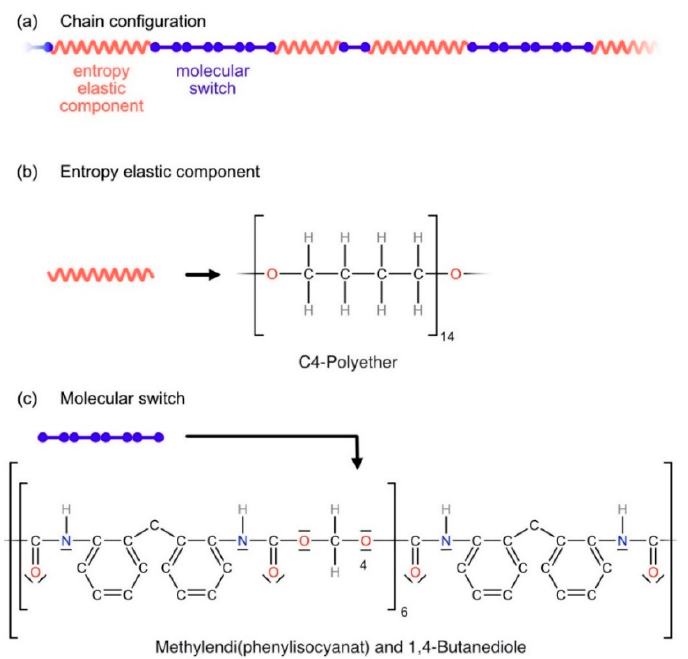
Figure 2. Schematic illustration of macromolecular structure of SMP actuators made from ESTANE ETE 75DT3 (SMP-E). ( a ) Macromolecular chain with two components: an entropy elastic component (red) and a molecular switch (blue). ( b ) Structural formula of elastic component. ( c ) Structural formula of molecular switch.